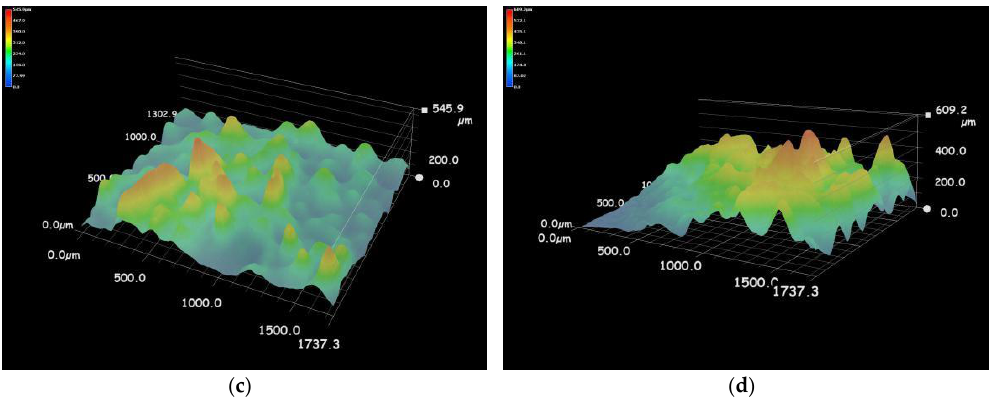
Figure 6. Depth of field three-dimensional microscopic images of PVA/PEO membranes. ( a ) 8 wt % PVA; ( b ) 8 wt % PVA/3 wt % PEO (90/10); ( c ) 8 wt % PVA/3 wt % PEO (80/20); ( d ) 8 wt % PVA/3 wt % PEO (70/30); ( e ) 3 wt % PEO.